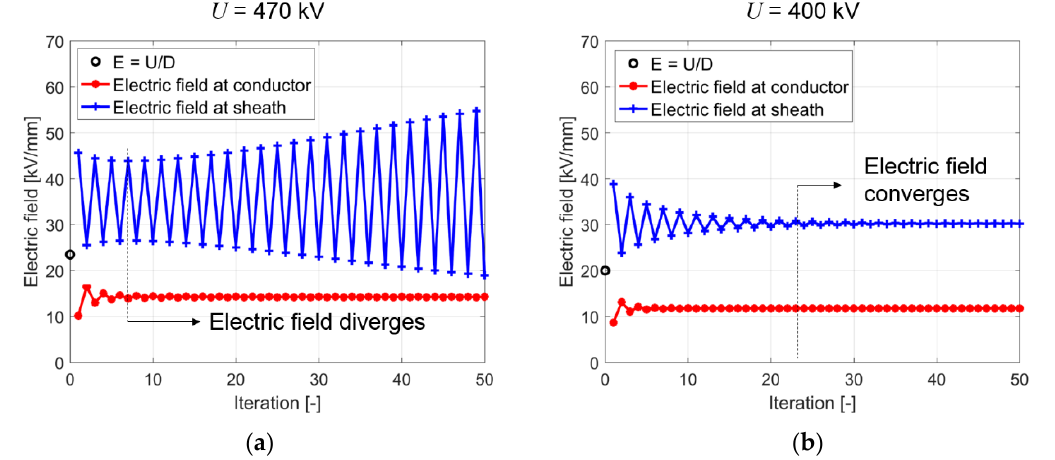
Figure 9. Electric field at the conductor and the sheath in a 20 mm-thick MI insulation. ( a ) with an applied voltage of U = 470 kV, the electric field diverges after 5 iterations; ( b ) with a reduced voltage of U = 400 kV, the electric field converges [71].